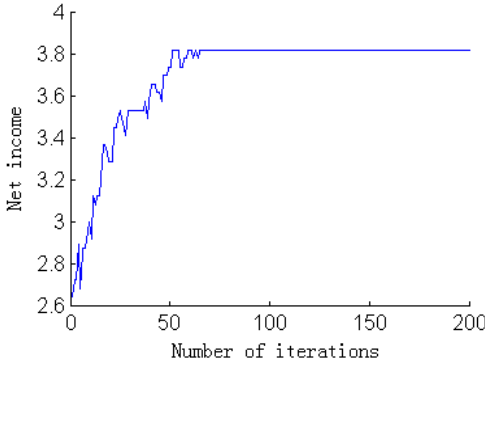
Figure 8. Solution convergence with the number of